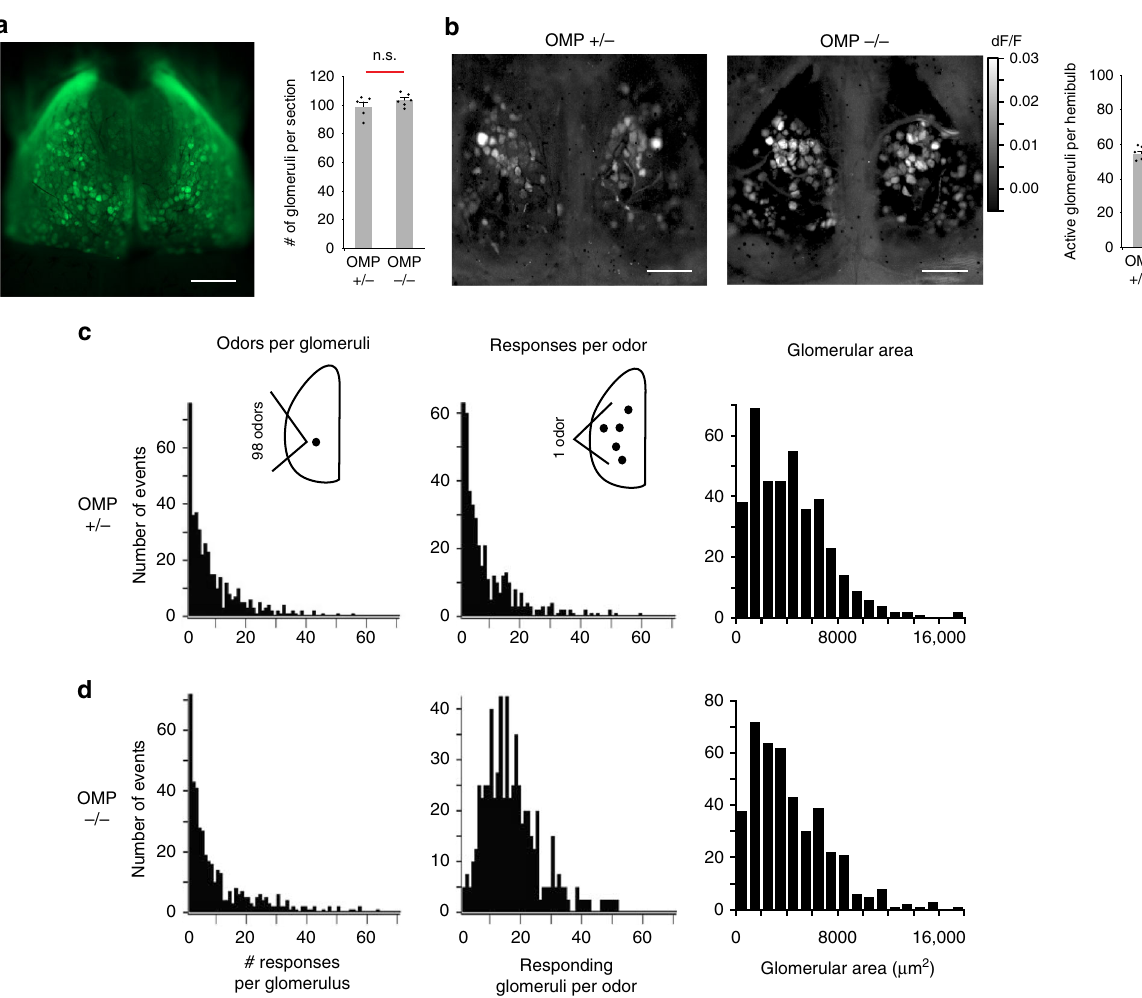
Fig. 1 Absence of OMP alters odor responses, but preserves macro-organization of the OB. a (Left) Wide fi eld view of dorsal surface of an OMP + / – mouse shows labeled glomeruli from the resting fl uorescence of spH. (Right) Quanti fi cation of the number of glomeruli per coronal section in central sections of the OB. Shown are 99 ± 3.44 glomeruli per coronal section for OMP + /- mice (mean ± SEM, n = 5 slices from 2 mice) and 104 ± 1.8 glomeruli per coronal section for OMP – / – (mean± SEM, n = 6 slices from 2 mice). b (Left) Maximum projection glomerular odor response maps for exemplar OMP + / – and OMP – / – mice to a panel of 99 odorants. (Right) Average number of responsive glomeruli per hemibulb to the odor panel (Supplementary Table 1). Shown are 53.9 ± 1.3 glomeruli per hemibulb for OMP + /- mice (mean ± SEM, n = 8 hemibulbs) and 72.6 ± 3.3 glomeruli per hemibulb for OMP – / – (mean± SEM, n = 6 hemibulbs). c , d (Left) Histograms of the number of odors to which a single glomerulus responds. (Center) Histograms of the number of glomeruli activated by an individual odor in the panel. (Right) Histograms of glomerular area in central coronal sections of the OB in OMP + / – and OMP – / – mice. n.s. indicates difference is not statistically signi fi cant, ** p < 0.005, Kolmogorov – Smirnov test; scale bar, 500 μ